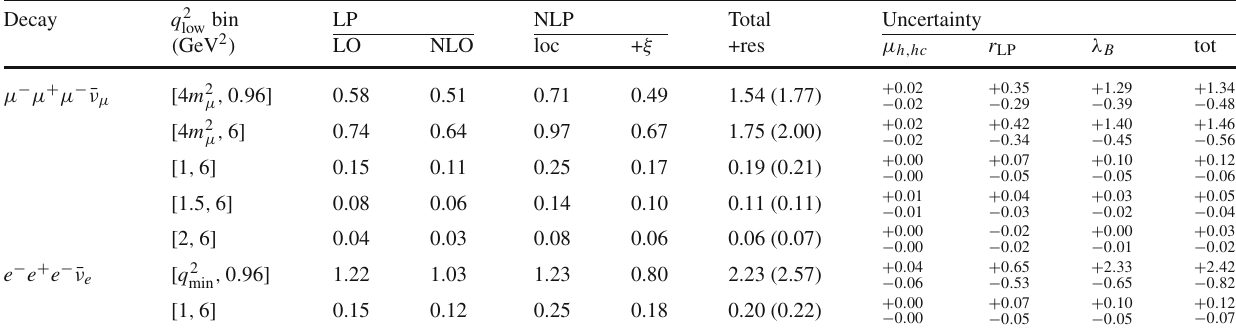
Table 3 Branching ratio for the two identical lepton cases (in 10 − 8 ) integrated over different bins in q 2 applying two cuts: n + q low > 3 low GeV and n + q high > 3 GeV. We show the individual contributions con- secutively adding to the LP result the NLP local and ξ